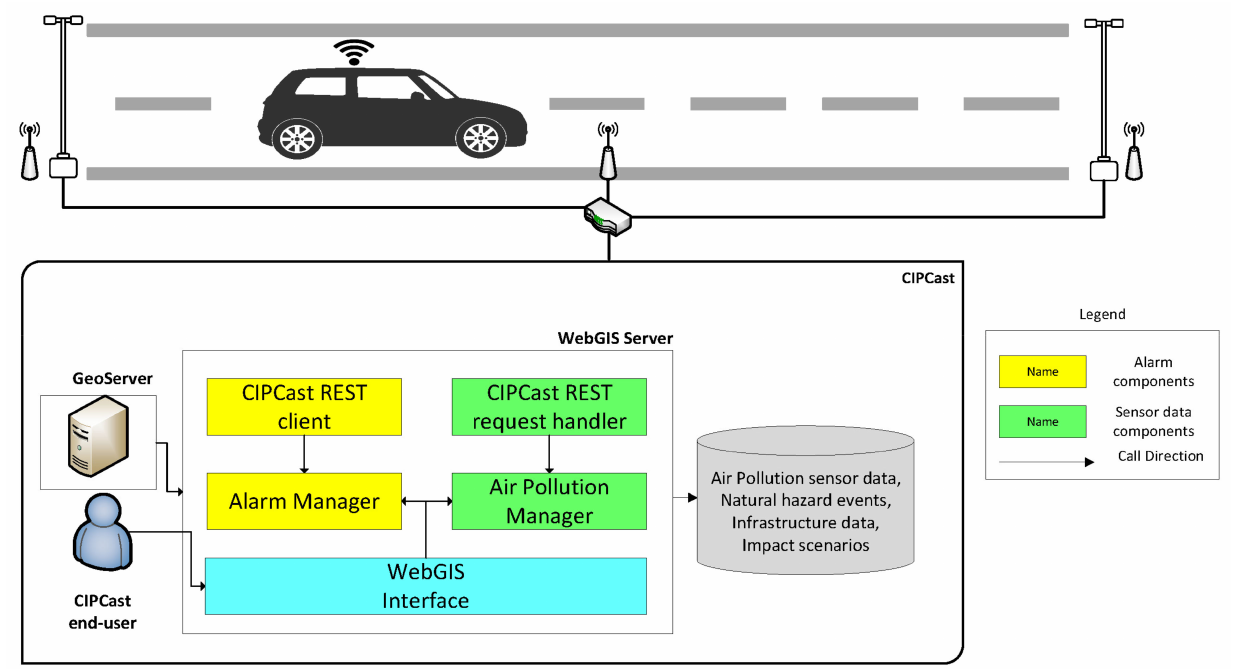
Figure 3. CIPCast–ER software architecture diagram.